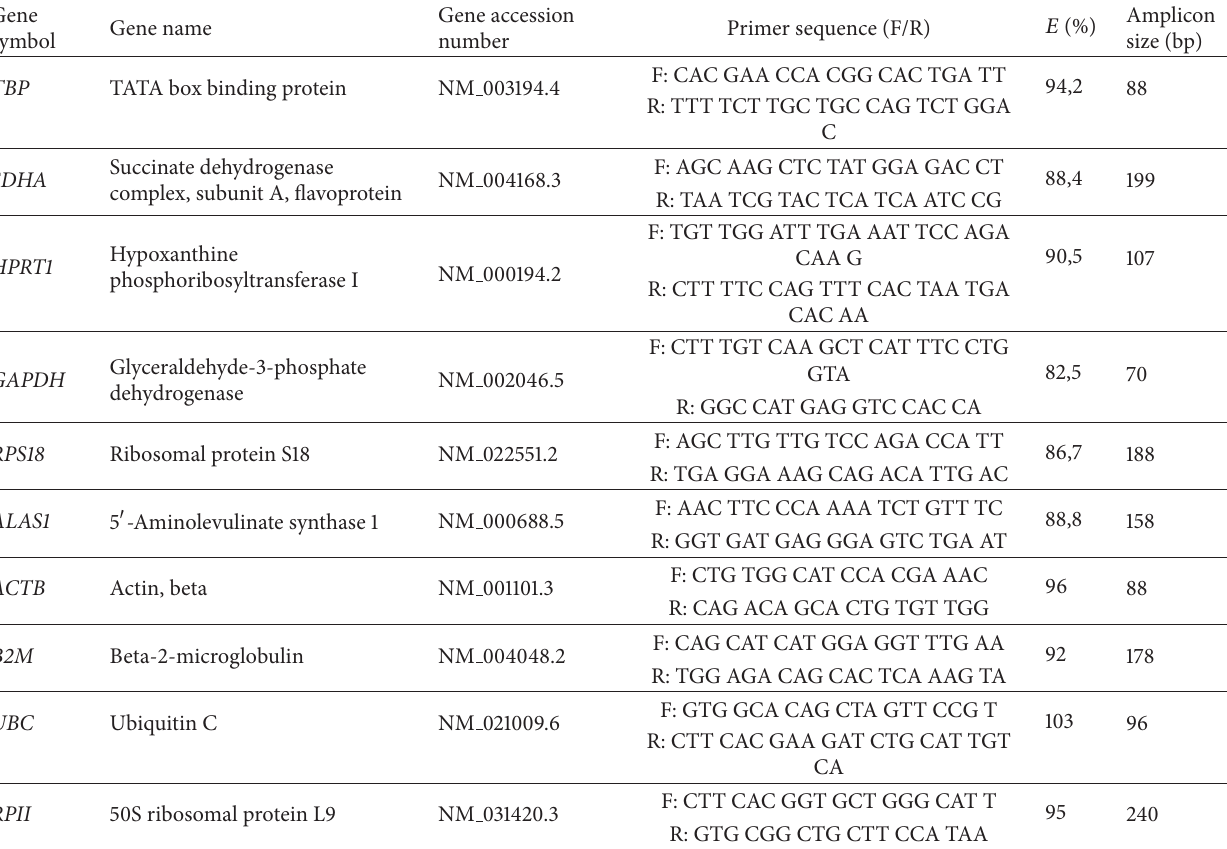
Table 1: 10 candidate housekeeping genes